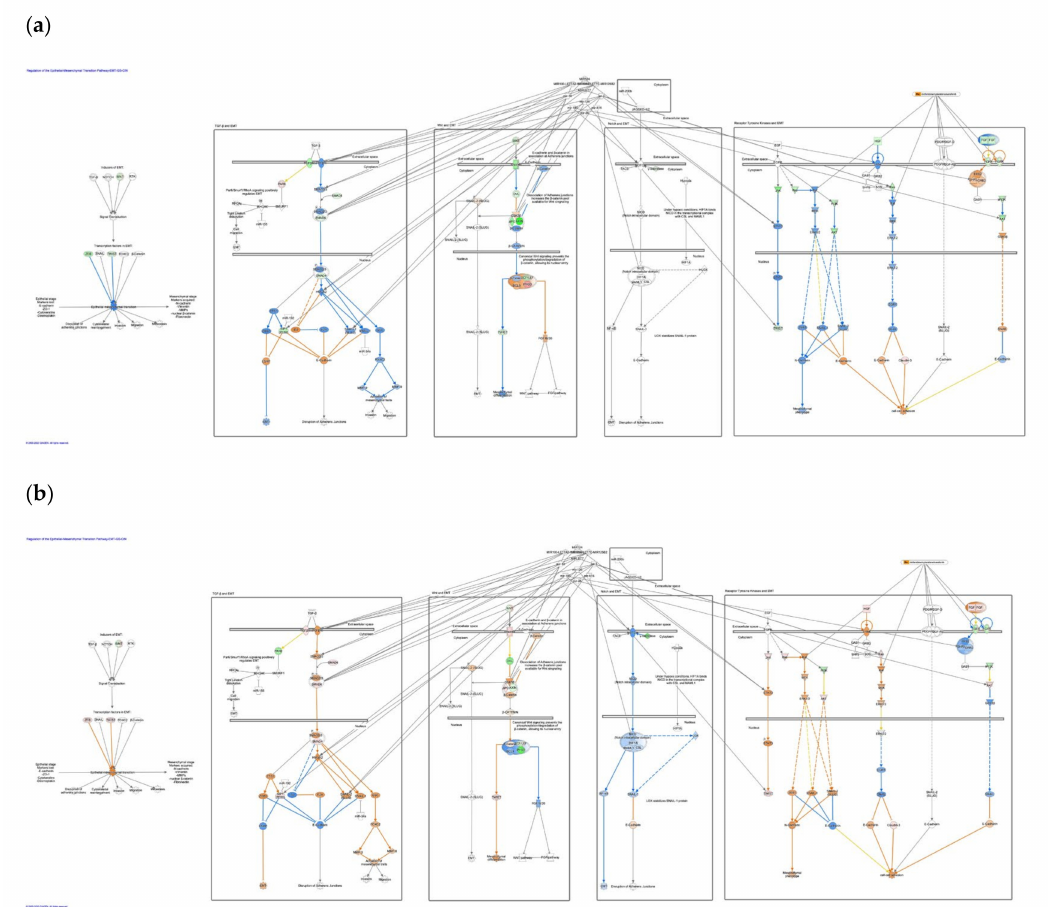
Figure 6. Canonical Pathways for Regulation of the EMT pathway in intestinal- and di ff use-type GC. Gene mapping and in silico prediction of the upstream and downstream e ff ects of activation or inhibition on molecules are shown in Canonical pathways for Regulation of the EMT pathway. The genes of which expression was altered in intestinal- and di ff use-type GC are shown in pink (up-regulated) or green (down-regulated). Predicted activation or inhibition is shown in orange or blue, respectively. ( a ) Gene expression and pathway activity prediction in intestinal-type GC are shown. ( b ) Gene expression and pathway activity prediction in di ff use-type GC are